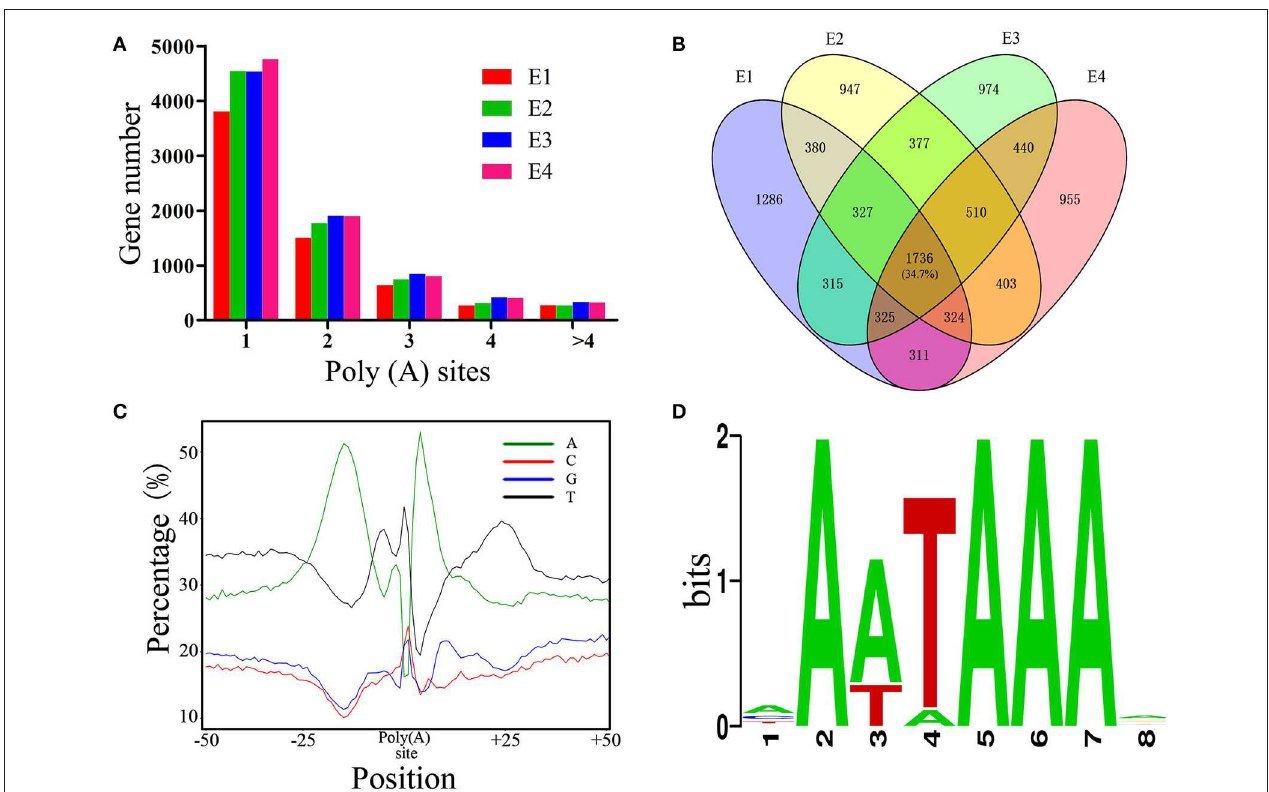
FIGURE 5 | Characterization of APA in chicken embryos. (A) Distribution of the number of poly(A) sites per gene generated during different stages of embryo development. (B) Venn diagram depicting the distribution of poly(A) sites among the 5,004 genes during different stages of embryo development. Each individual cell in the diagram represents the 5,004 genes, and the overlap represents the number of genes that have the same poly(A) sites. (C) Nucleotide composition around poly(A) cleavage sites. (D) The most enriched motif in the 50 bp sequence upstream of the poly(A) tail detected by